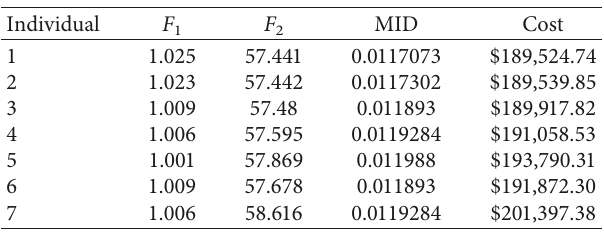
Figure 15: Optimal beam and column sections for levels 4–6 of individual 1, model RC-6. Table 5: Best individuals for model RC-9.